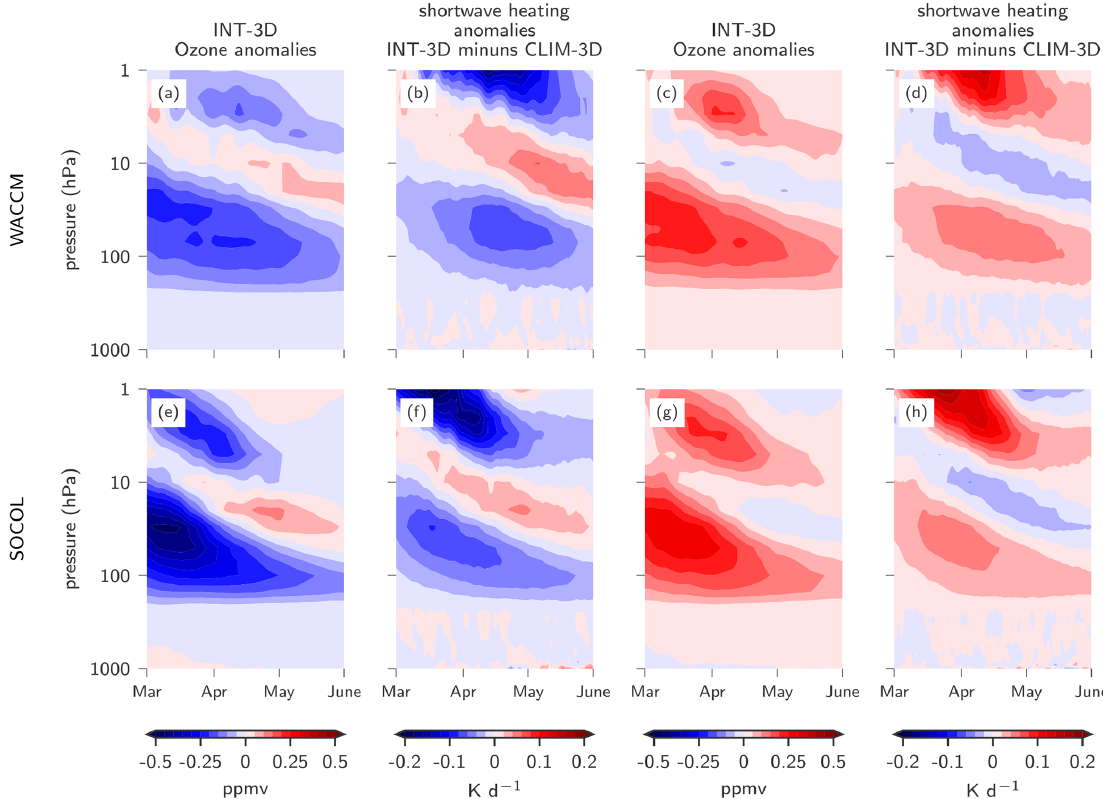
Figure A6. Ozone and shortwave heating anomalies in high- and low-ozone springs. Ozone anomalies in experiments with interactive ozone chemistry in low-ozone (a, e) and high-ozone (c, g) springs and differences in shortwave heating anomalies between INT-3D and CLIM-3D in low-ozone (b, f) and high-ozone (d, h) springs in WACCM (a–d) and SOCOL-MPIOM (e–h) .